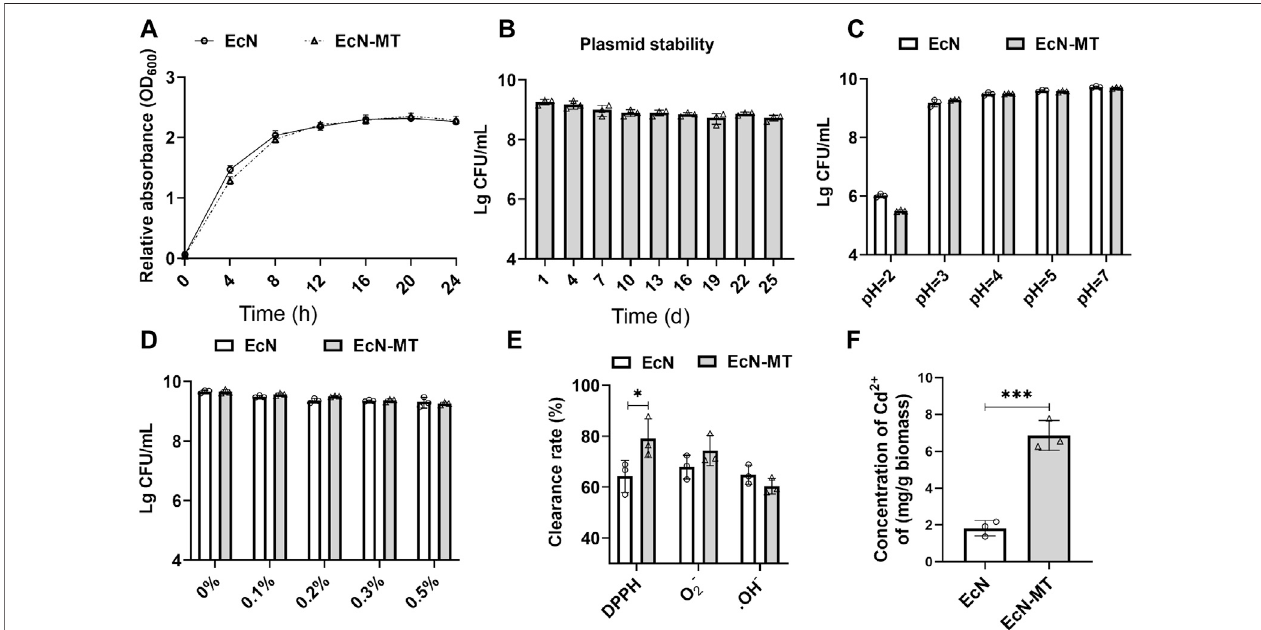
FIGURE1| EvaluationoftheprobioticcharacteristicsofEcN-MT.Valuesarepresentedasmeans±SD( n =3). (A) GrowthcurvesofEcNandEcN-MT. (B) Plasmid stability test of EcN-MT. (C) The acid tolerance of EcN and EcN-MT. (D) The cholate tolerance of EcN and EcN-MT. (E) The antioxidant ability of EcN and EcN-MT. (F) The ability of EcN and EcN-MT to bind cadmium ions. * p <